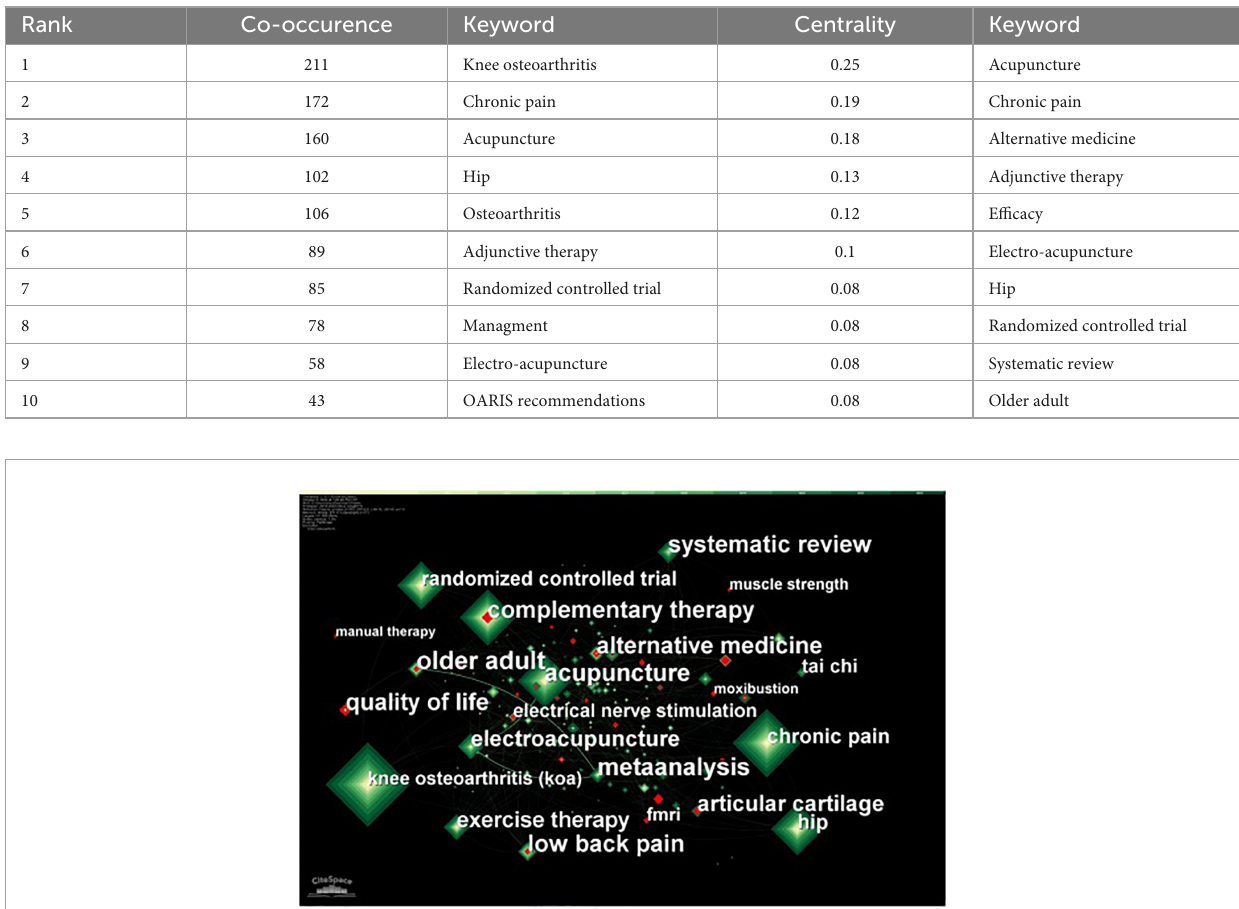
FIGURE8 The timeline map of co-occurrence keywords related to traditional Chinese non-pharmacological therapies on knee osteoarthritis (KOA).